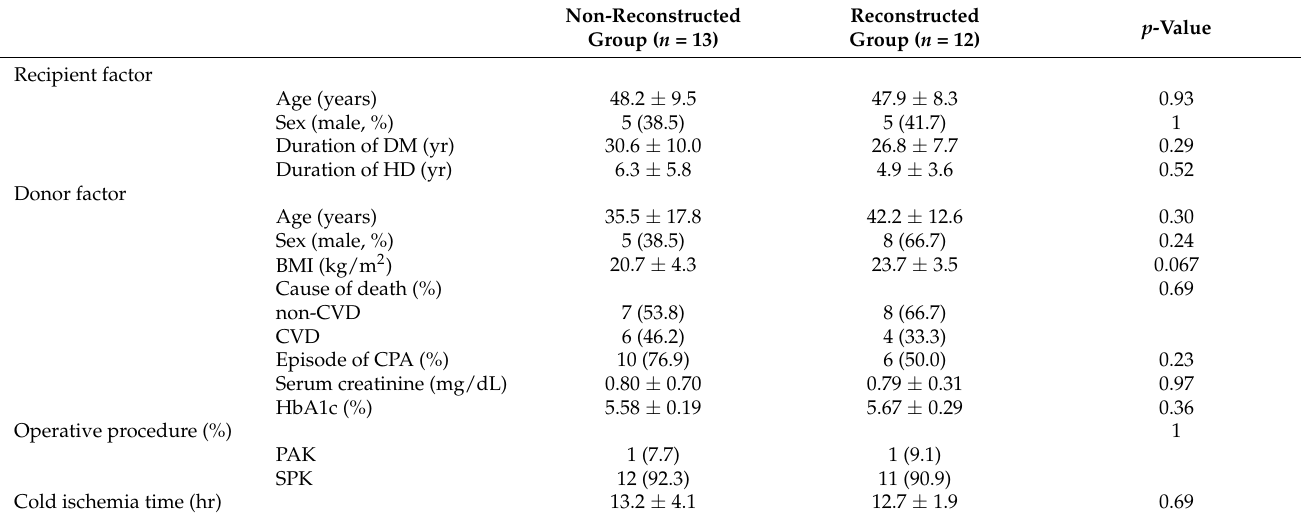
Table 1. Recipient and donor background of both the